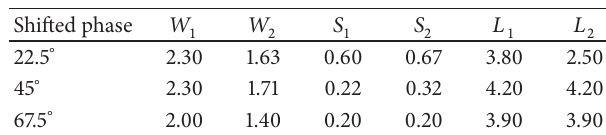
Table 1: The structural parameters of phase shifters with different shifted